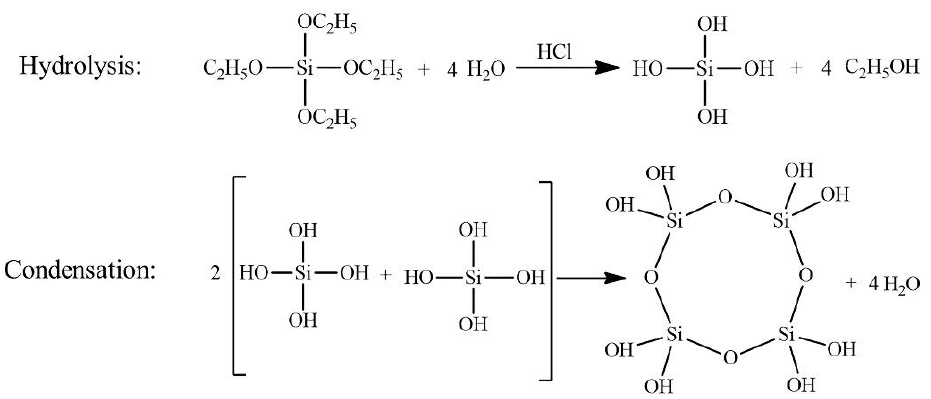
Figure 13. The reaction proce ss of SA.